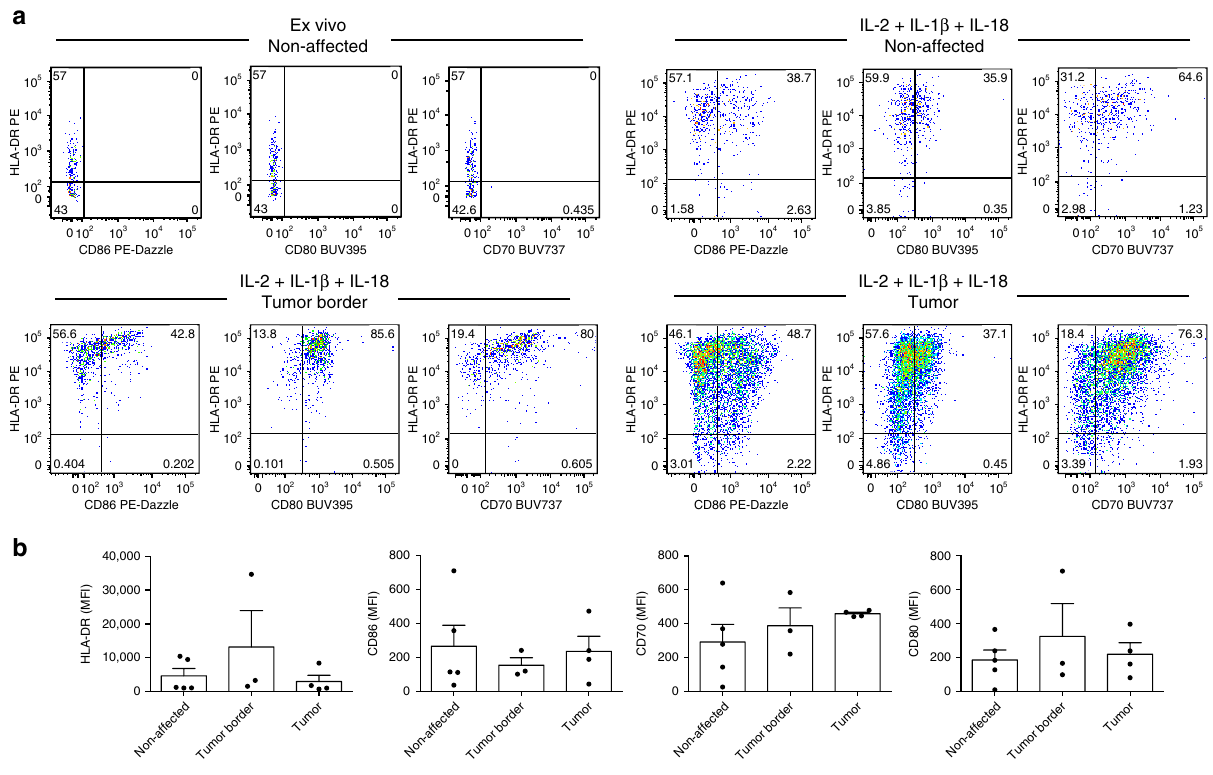
Fig. 7 HLA-DR and co-stimulatory molecule expression on intestinal ILCs ex vivo or following IL-2 plus IL-1 β and IL-18 stimulation. a Representative plots and b MFI of HLA-DR, CD70, CD80, and CD86 expression on ex vivo ( a ) and sort-puri fi ed ( a , b ) ILCs isolated from non-affected colon, tumor border and central tumor areas expanded for 7 – 9 days in the presence of IL-2 plus IL-1 β and IL-18. N (patients) = 5. Not all sub-anatomical regions could be obtained for every donor; source data are provided as a source data fi le. Bars and error bars indicate mean and